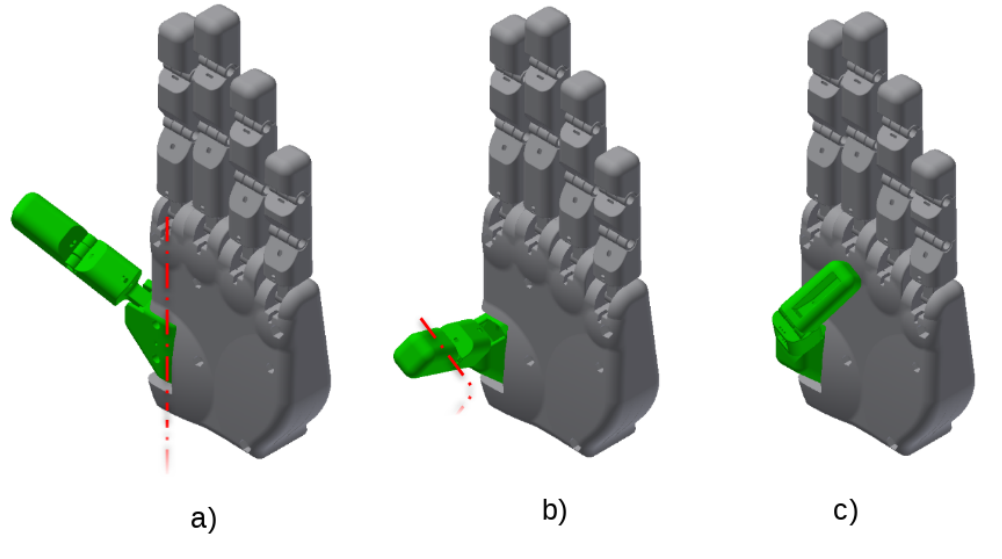
Figure 6. Coordinated flexion of the thumb relative to an axis of rotation parallel to the hand.